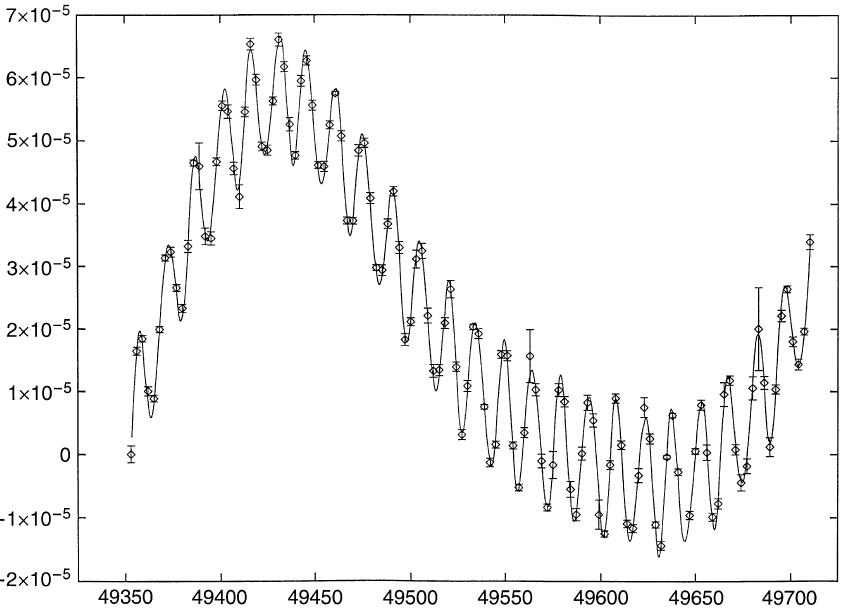
Fig. 4. The change in inclination of Stella due to ocean tides from the